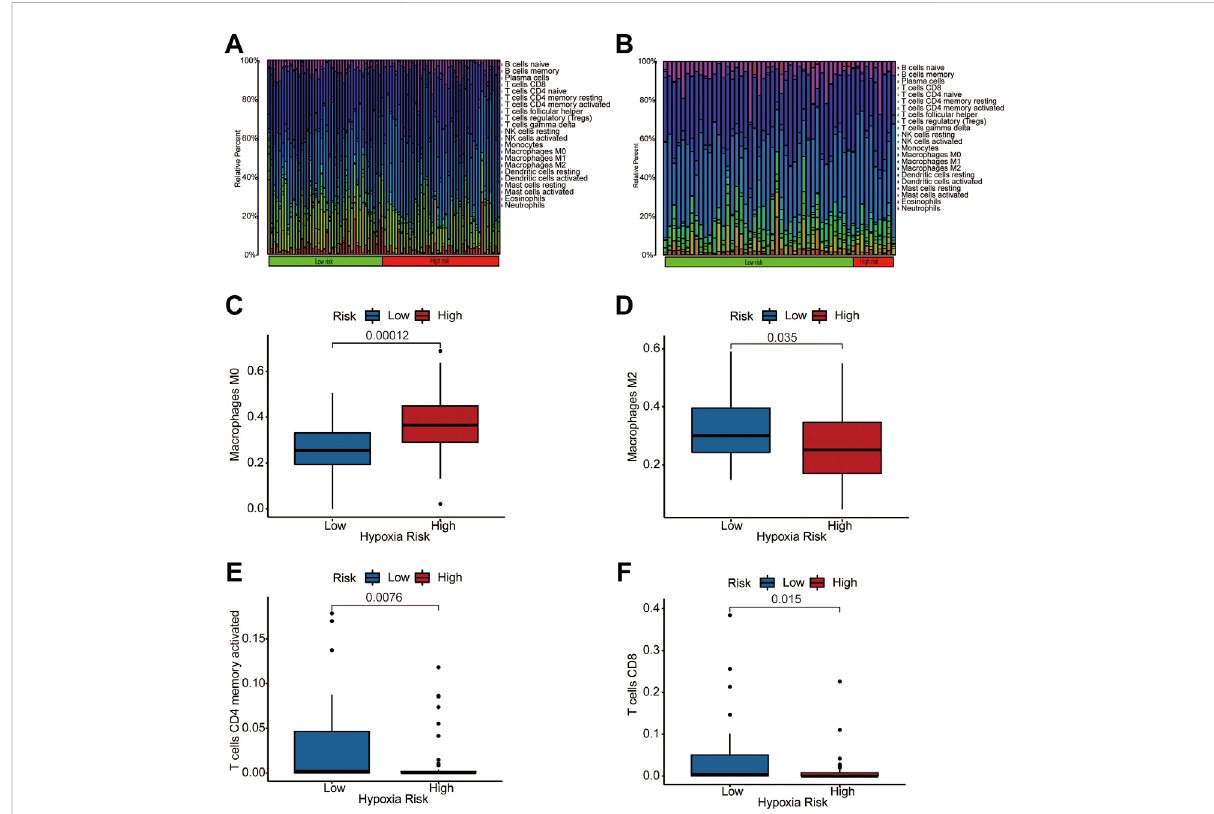
FIGURE 5 Theimmunelandscapeoftwohypoxiascoresubtypes. (A,B) Distribution ofimmunein fi ltrationinpatientsofhigh-andlow-hypoxiariskgroups from TARGET (A) and GEO (B) databases; (C – F) Comparison of various immune cells between high- and low-hypoxia risk groups from training dataset, visualized by Box